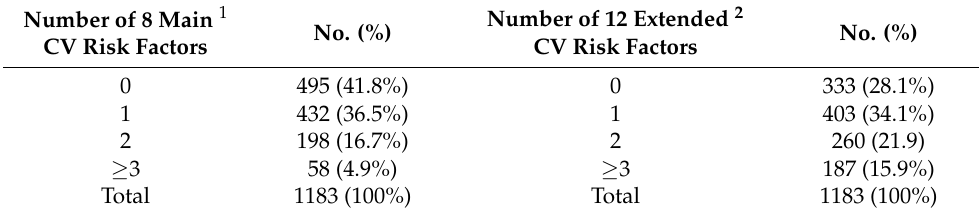
Table 2. Presence of CV risk factors among students. 1 BMI > 24.9 kg/m 2 , active smoking, hyperten- sion, dyslipidemia, diabetes, CV family history, inadequate diet and inadequate physical activity. 2 Eight main CV risk factors + BMI ≤ 18.5 kg/m 2 , alcohol abuse, drug use, sleep time <6 h or >9